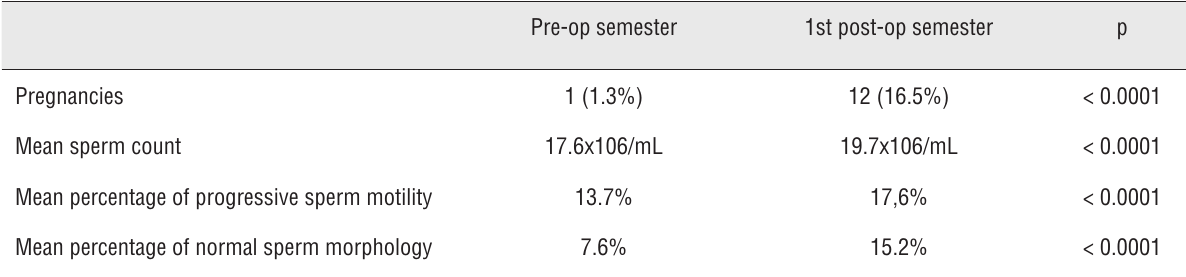
Table 1 - Pregnancies and sperm characteristics before and after operation.